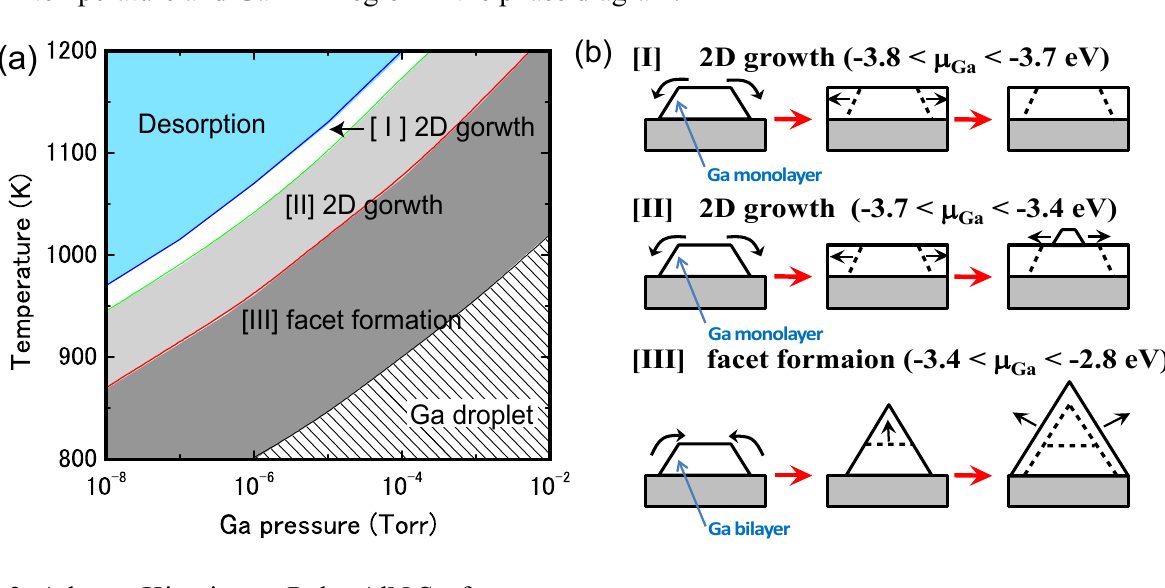
Figure 32. ( a ) Calculated phase diagrams for growth modes as a function of temperature a Ga BEP and ( b ) growth mode schematic representations with each corresponding to each temperature and Ga BEP region in the phase